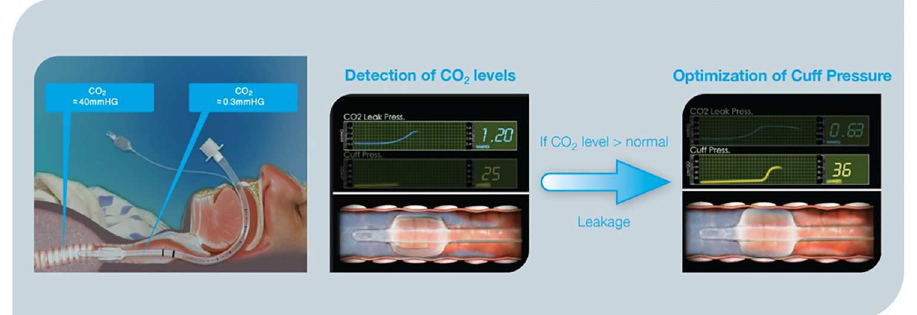
Fig 6. Automatic endotracheal tube cuff pressureclosed loop adjustment.